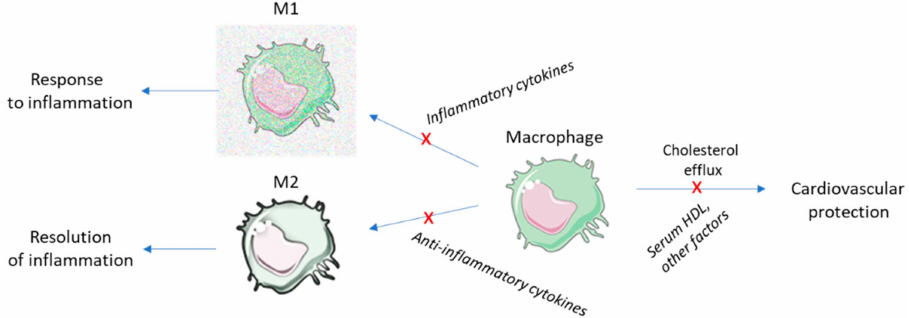
Figure 1. Alterations in macrophage functional phenotypes in PCOS. Macrophages are plastic cells that respond to pro- and anti-inflammatory stimuli to adjust to environmental changes and maintain homeostasis. Compared with healthy women, blood-derived macrophages from PCOS women are impaired in their response to cytokines, suggesting a reduced capacity to adjust to microenvironmental changes in di ff erent conditions. In addition, the serum from PCOS women is less e ff ective in promoting cholesterol e ffl ux from macrophage cell models with respect to that from healthy women. Cholesterol e ffl ux is driven by serum HDL subfractions but also by other cellular and circulating factors. Impaired cholesterol e ffl ux capacity is associated with an increased risk for atherothrombotic events. X: impairment observed in PCOS women vs.